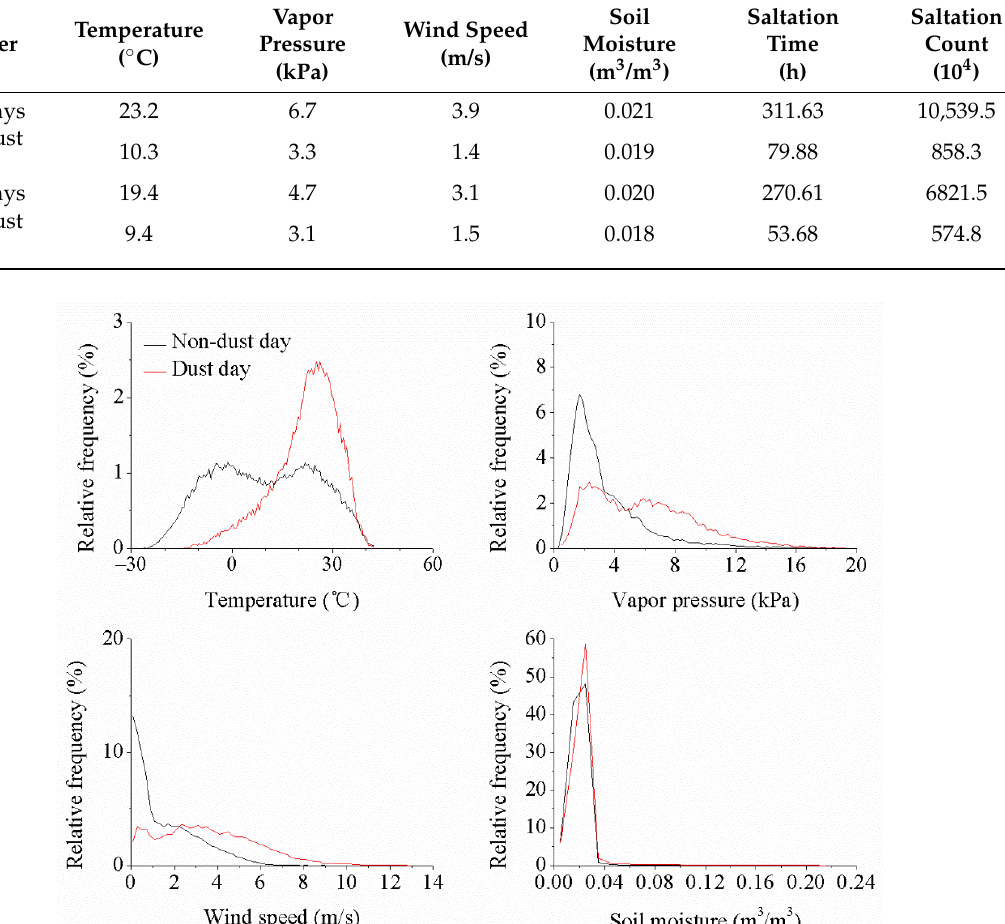
Table 1. Total saltation activity and atmospheric and soil conditions on dust and non-dust days from March 2008 to February 2010.